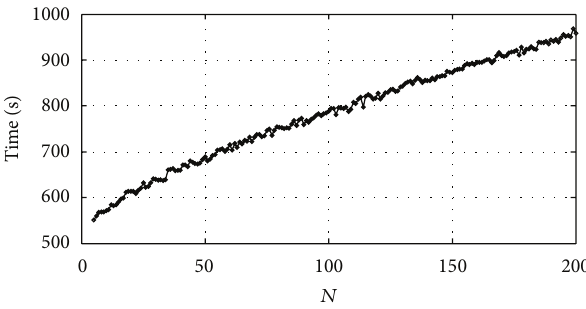
Figure 7: Relationship between running time and 𝑁 .